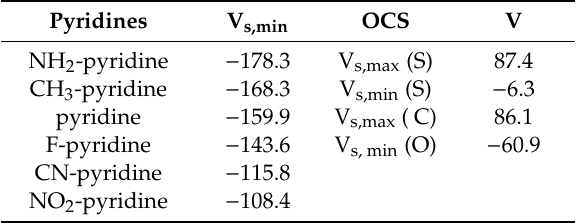
Electrostatic potentials (V in kJ / mol) of pyridines a and OCS calculated at the MP2 = full / aug-cc-PVDZ level. Pyridines V